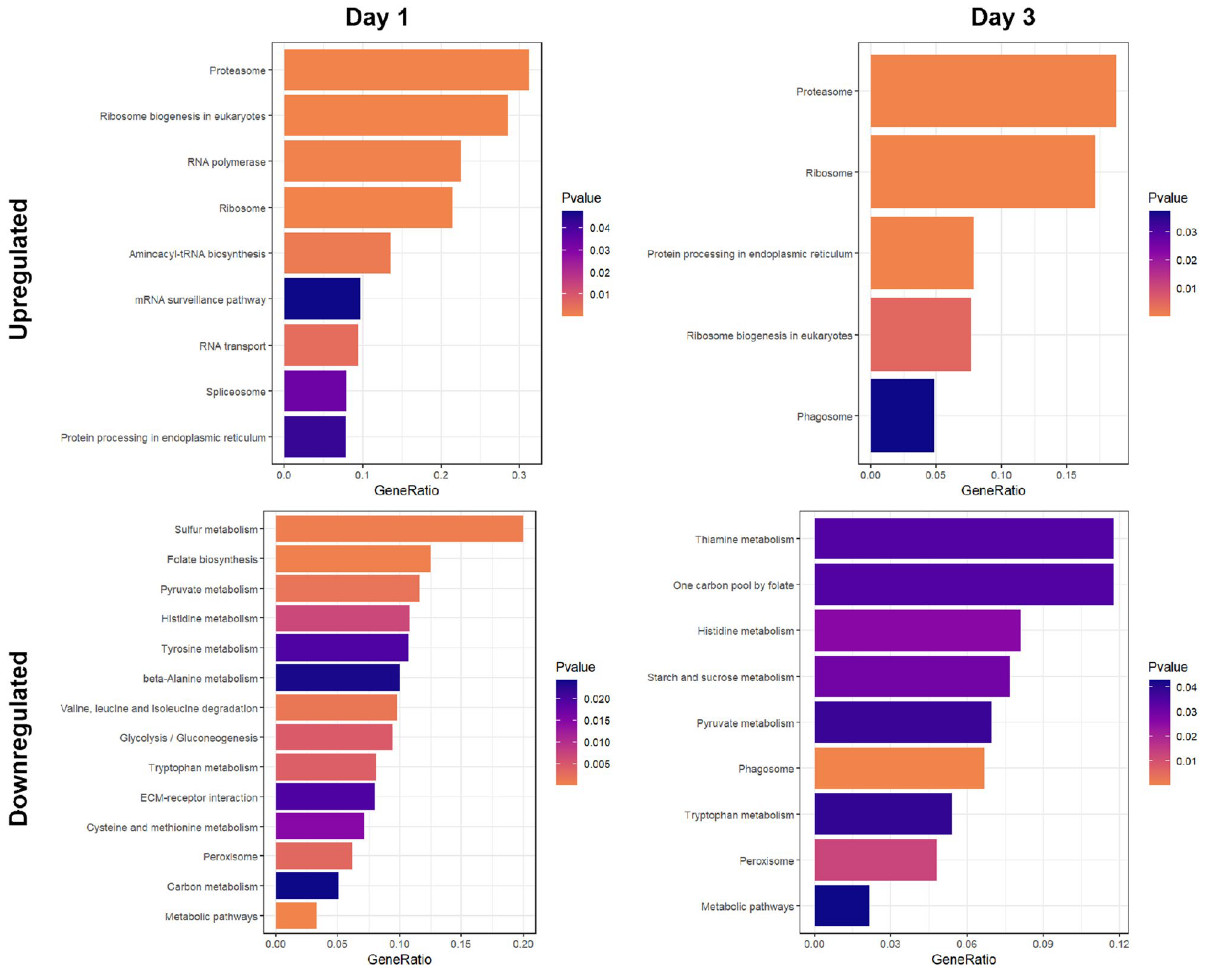
Figure 4. Pathway enrichment analysis of differentially expressed genes (DEGs) at day 1 and day 3 of regeneration using KEGG database. The GeneRation is a measure of the number of genes in the differentially expressed set divided by the total number of genes for that specific pathway found in